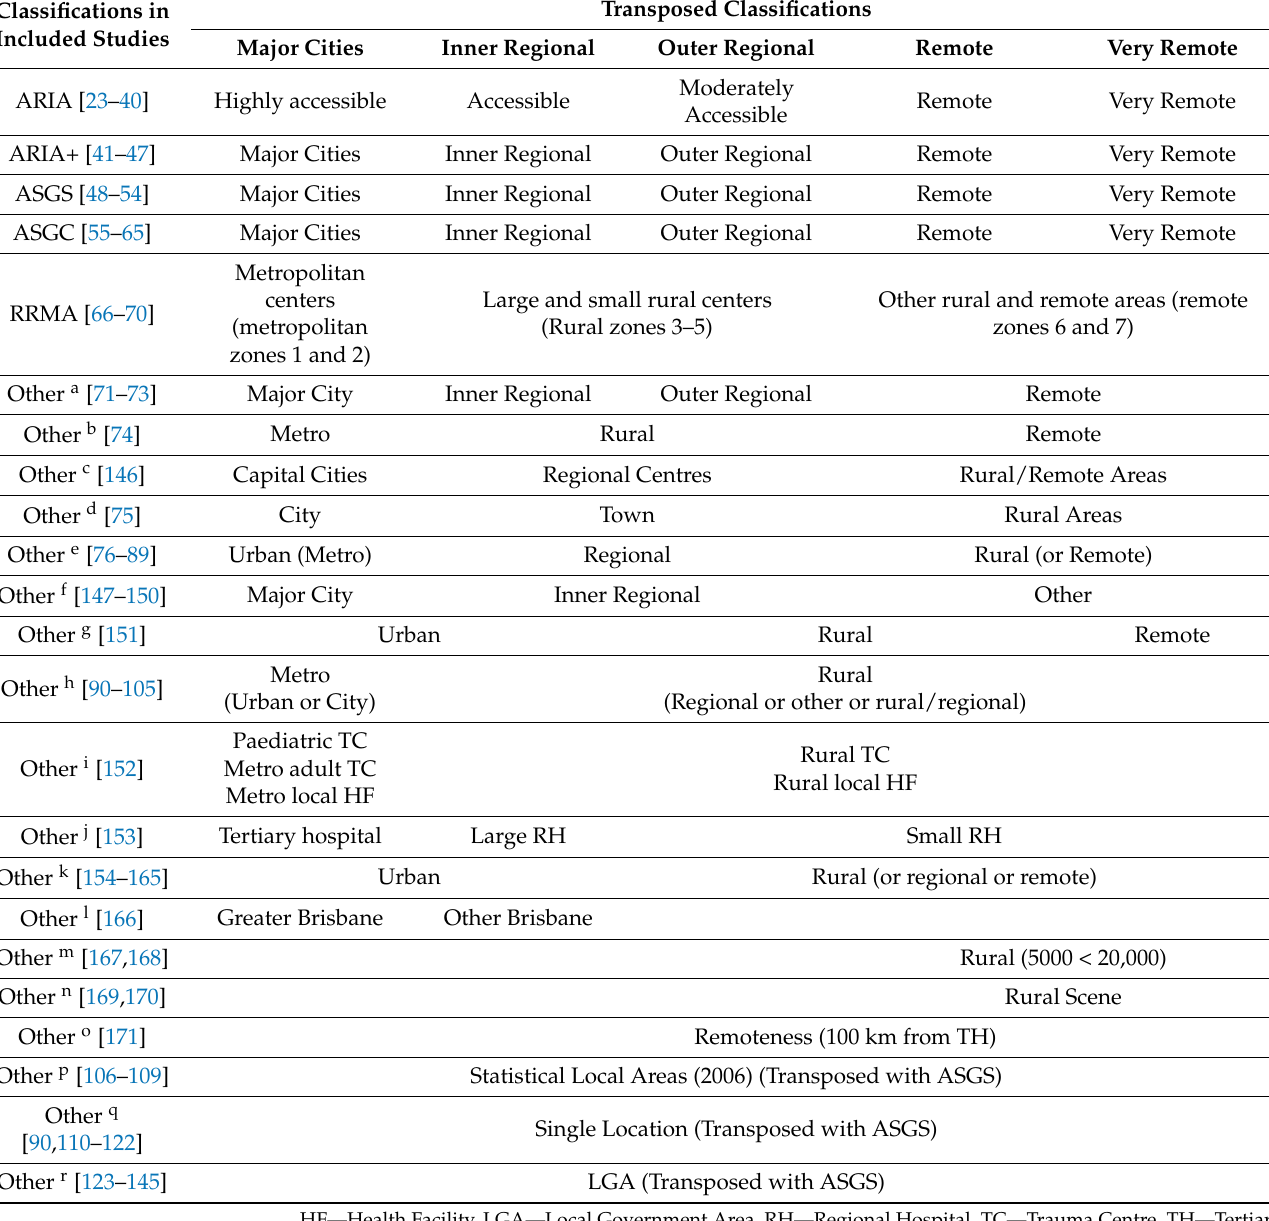
Table 2. Transposition of Remoteness